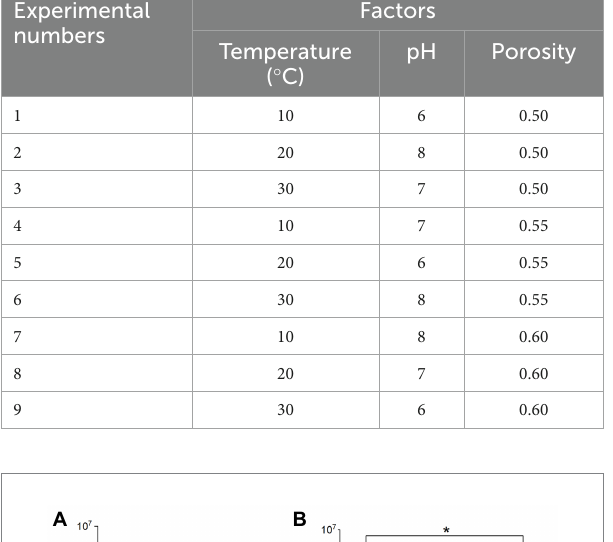
TABLE 1 The orthogonal table with three factors and three levels.